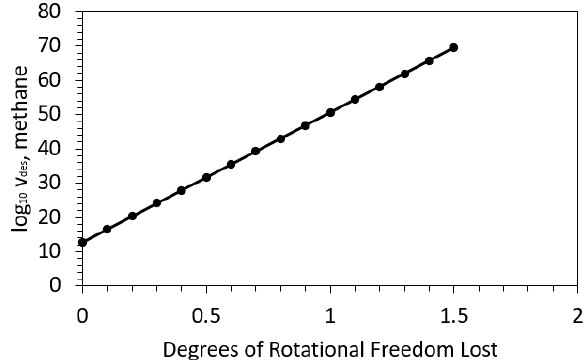
Figure 9. A plot of the logarithm of the pre-exponential factor of methane desorption against the degrees of rotational freedom lost upon adsorption.